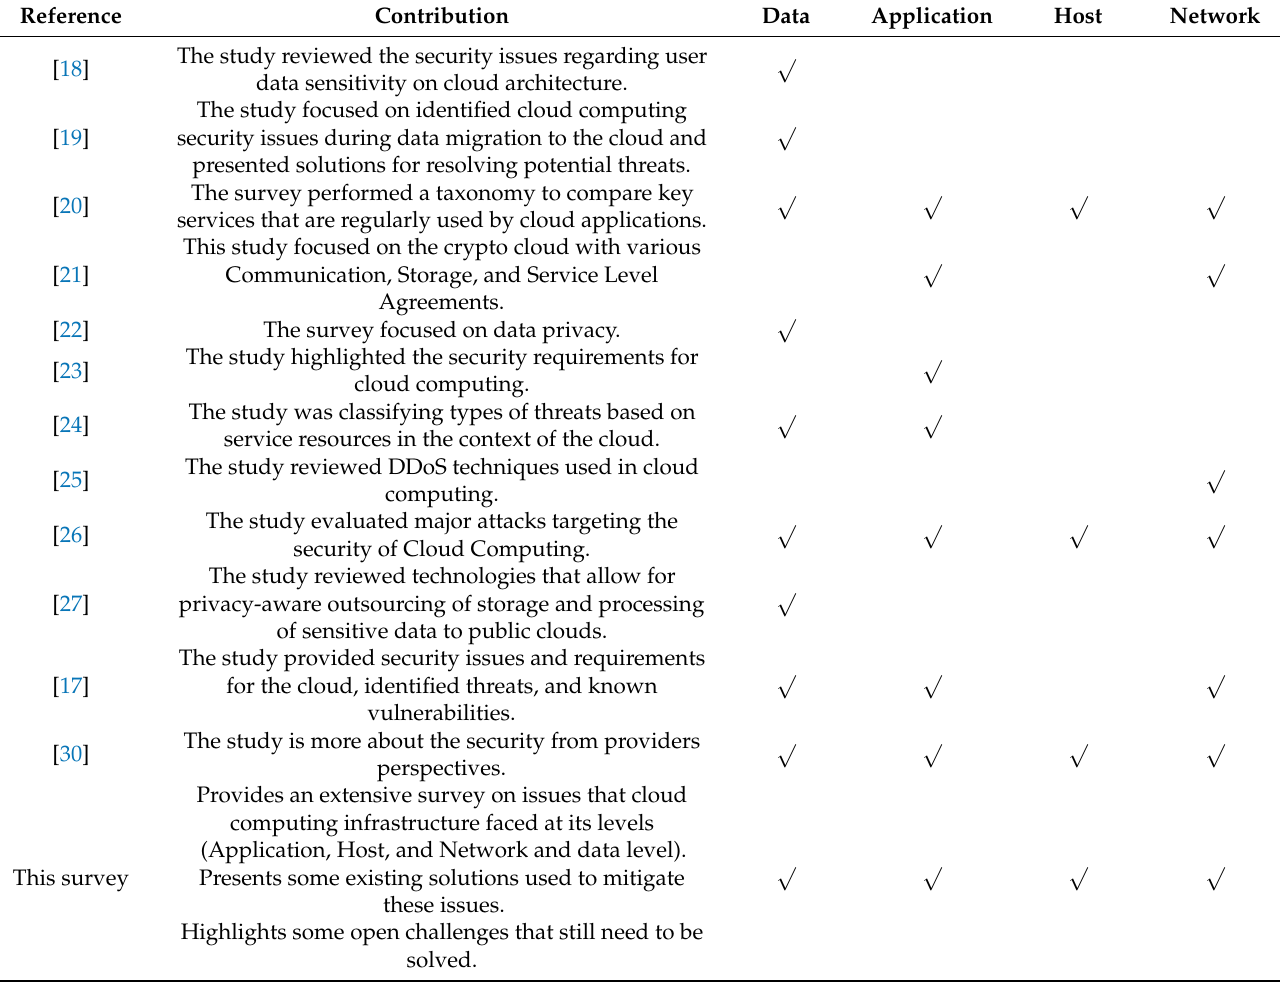
Table 2. Summary of existing